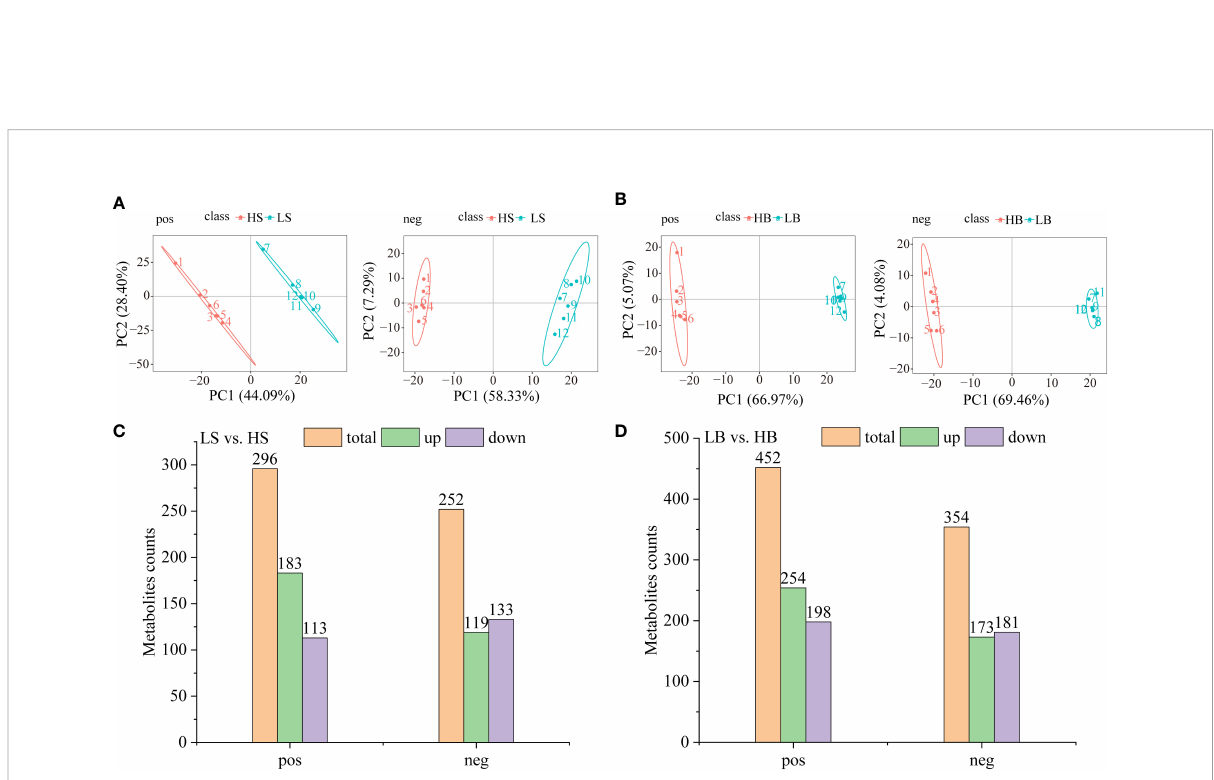
FIGURE 9 Differential metabolites of H ammodendron and H persicum under drought stress. (A) Principal component analysis scores of the two groups of samples of ( H ammodendron in positive ion (pos) and negative ion mode (neg). (B) Principal component analysis score maps of the two groups of samples of H persicum in positive ion (pos) and negative ion mode (neg). (C) DEMs of H ammodendron in positive and negative ion mode. (D) DEMs of H persicum in positive and negative ion